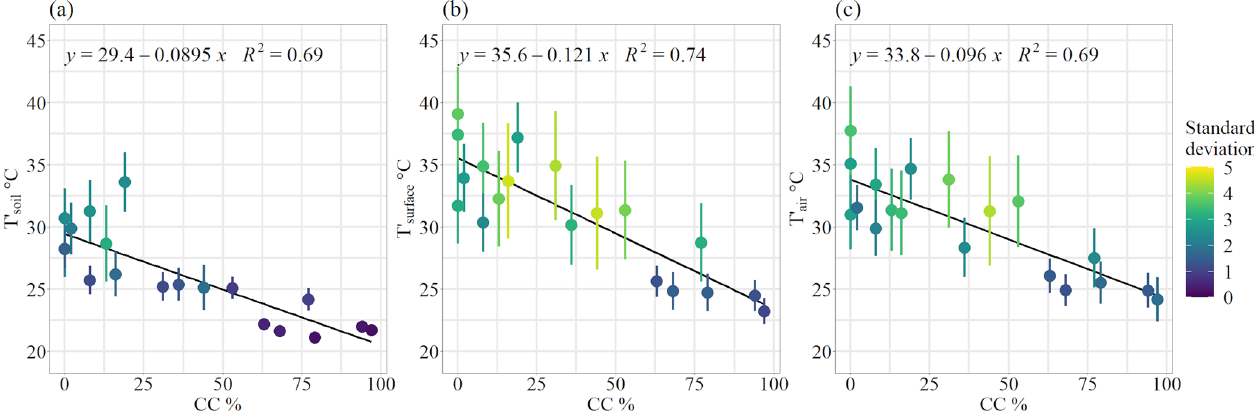
Figure 3. Scatterplots of topographically corrected daytime maximum temperatures ( T (cid:48) ) and standard deviation against canopy cover (CC)